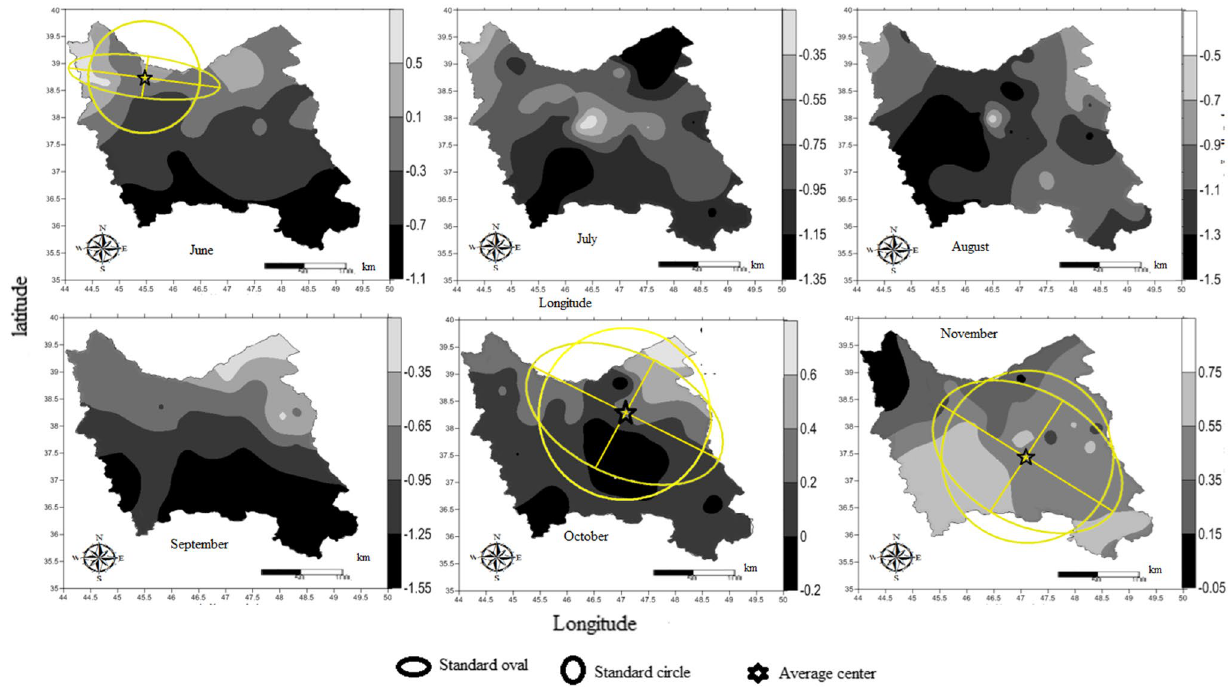
Fig. 5 Spatial distribution of monthly values SPI of summer and autumn and their distribution and central indices in northwest of Iran. Source : Nega-